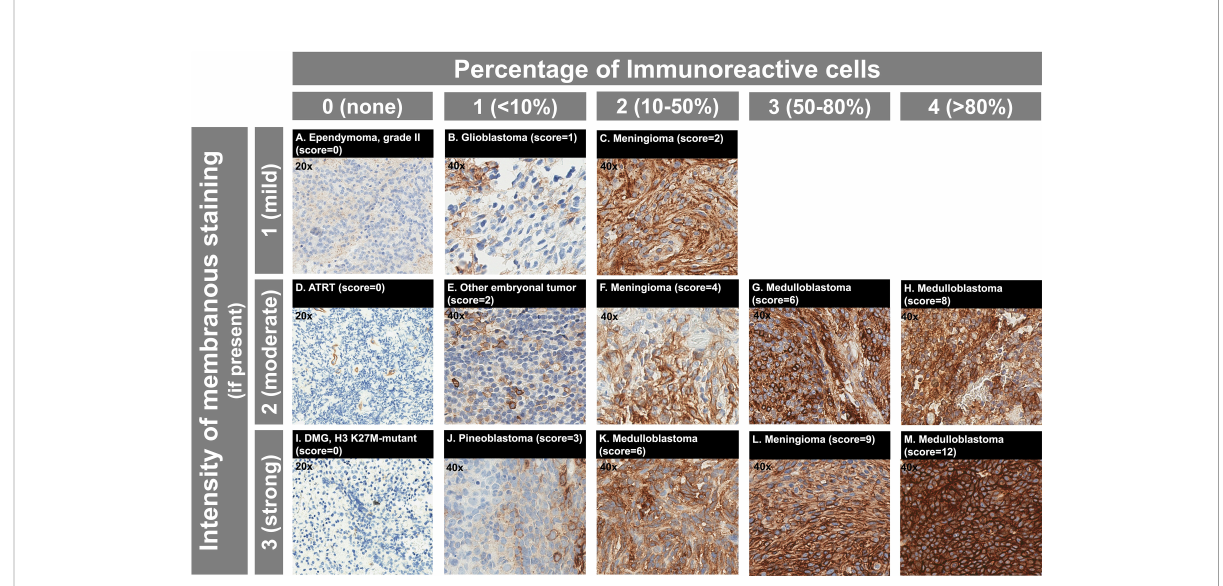
FIGURE 1 SST2A IHC scoring system with example cases from the analyzed pediatric CNS tumor cohort. (A – M) Immunoreactive cell percentage is illustrated horizontally, with scores ranging from 0 (none) to 4 (>80%) shown. Staining intensity is illustrated vertically, with scores ranging from 1 (mild) to 3 (strong) shown for tumors with membranous expression present. Total SST2A IHC score (calculated from multiplying immunoreactive cell percentage and staining intensity scores) is noted in parentheses for each example, with the respective histopathologic diagnosis speci fi ed. Note that all three cases in the fi rst column (A , D , I) had entirely absent membranous SST2A expression within viable tumor and received total SST2A IHC scores of 0; images for these cases are shown at 20x magni fi cation. Endothelial staining serves as a positive internal control (D) . For all other cases, images are shown at 40x magni fi